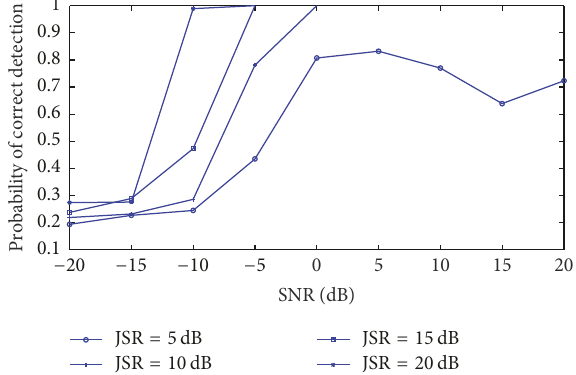
Figure 10: The jamming suppression result using 𝐻(𝑓) ( 𝑇 𝑠 = 10𝜇 s).